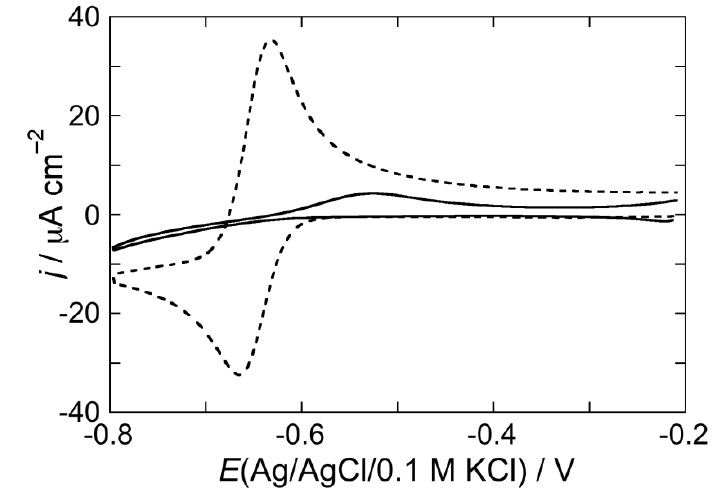
Figure 5. Cyclic voltammogram at a DOPC SAM in a pH 5.4 unbuffered solution of 0.1 M KCl, 4 × 10 −5 M CdSO 4 and 2 μg/mL of the type I’ β -turn peptide structure CSF114 (solid curve). The dashed curve is the cyclic voltammogram at bare mercury in an unbuffered solution of 0.1 M KCl and 4 × 10 −5 M CdSO 4 . Scan rate = 0.05